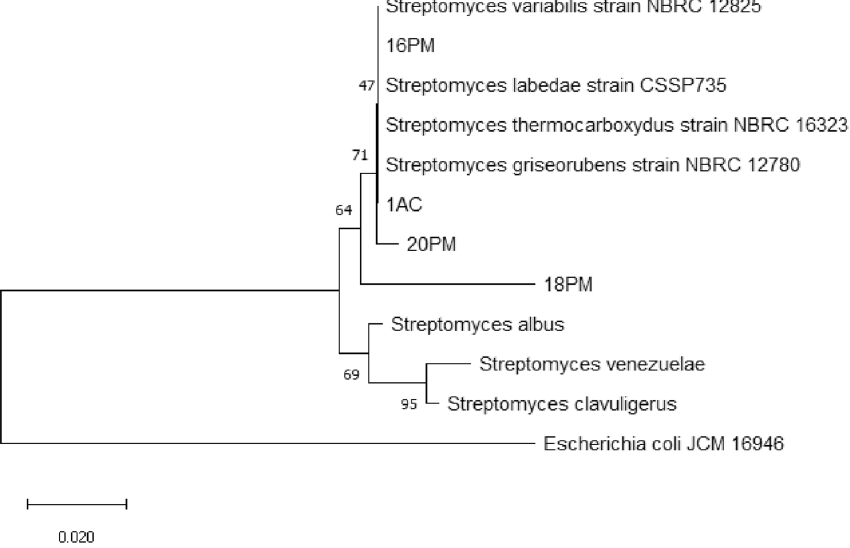
Figure 8. Phylogenetic tree of Streptomyces based on the 16S rRNA gene sequence. The bar indicates a distance of 0.020 substitutions per